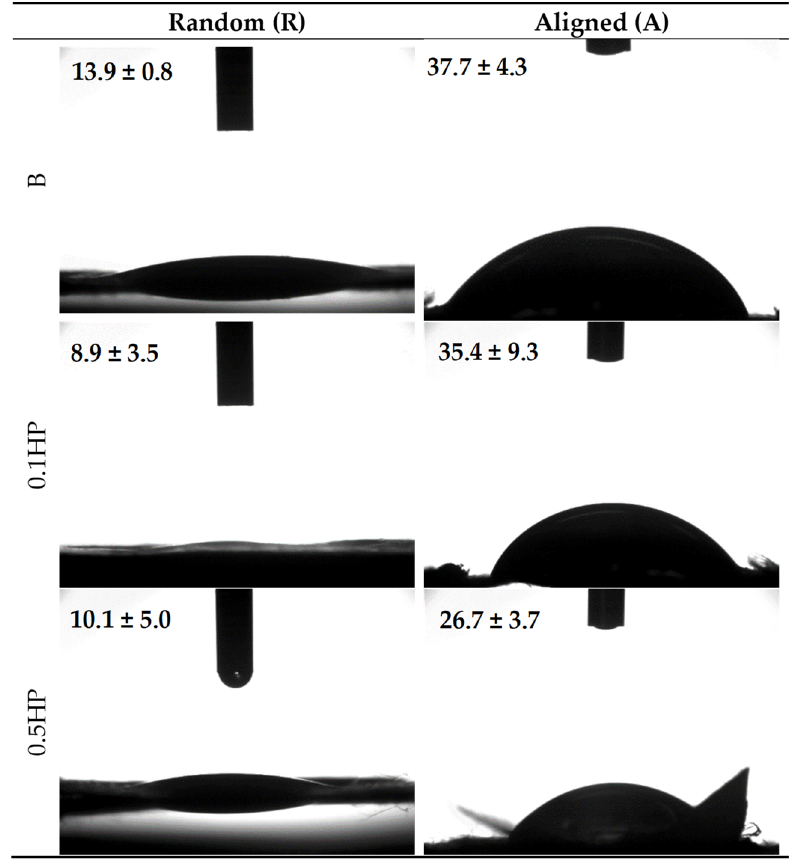
Figure 4. Images of the buffer drop onto the scaffold surface after 1000 ms. In each image, the value of the contact angle is reported (mean values ± s.d.; n = 3) (needle diameter = 0.405 mm).